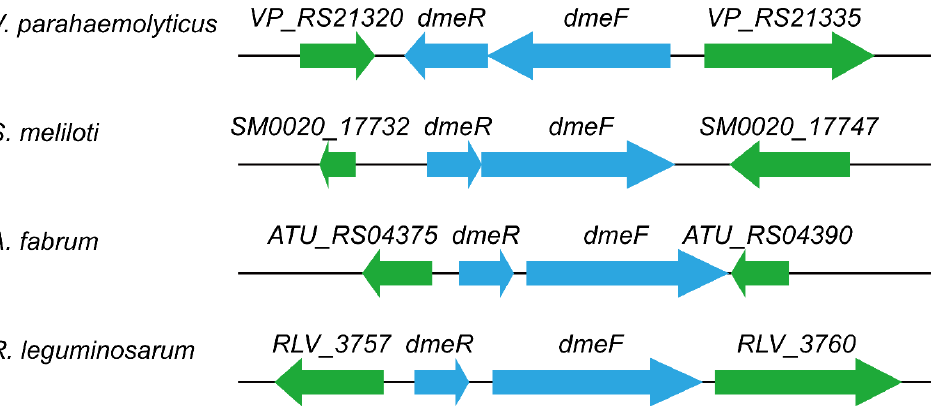
Figure 1. Genetic structures of the dmeRF systems in V. parahaemolyticus and several Rhizobiaceae species. Arrows indicate the direction of transcription. The structure analyses were performed using the following genomes: V. parahaemolyticus RIMD 2210633, NC_004605.1; S. meliloti CCNWSX0020, AGVV01000035.1; A. fabrum C58, NC_003062.2; and R. leguminosarum UPM791, CP025509.1.